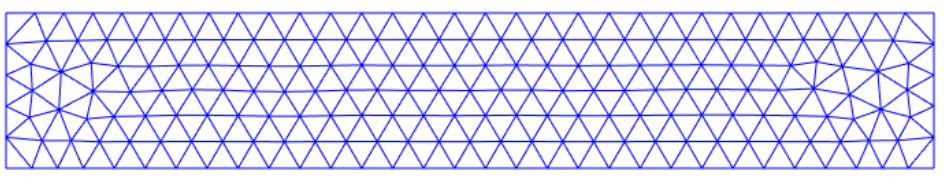
Figure 13. Part with uniform infill density of 26%.